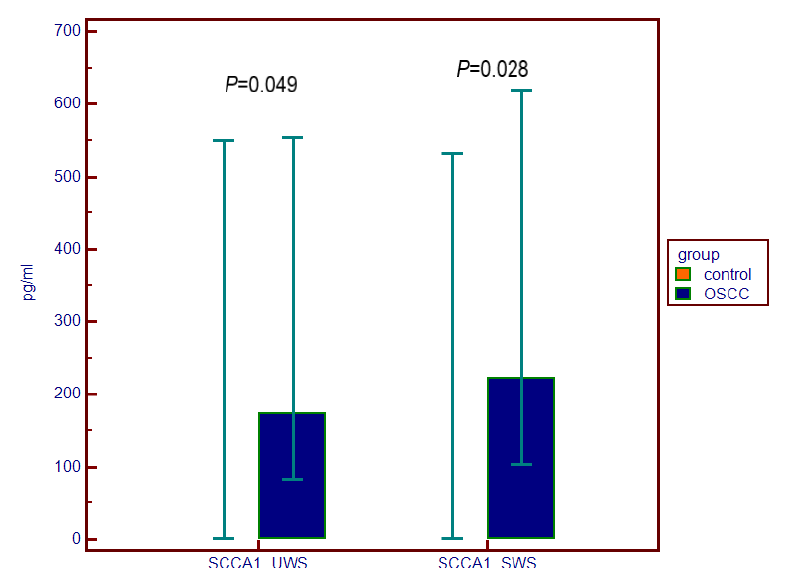
Figure 1. SCCA1 levels (pg/mL) in unstimulated whole saliva (UWS) and stimulated whole saliva (SWS) in patients with oral squamous cell carcinoma (OSCC) and in the control group expressed with median and the 25th–75th percentiles.